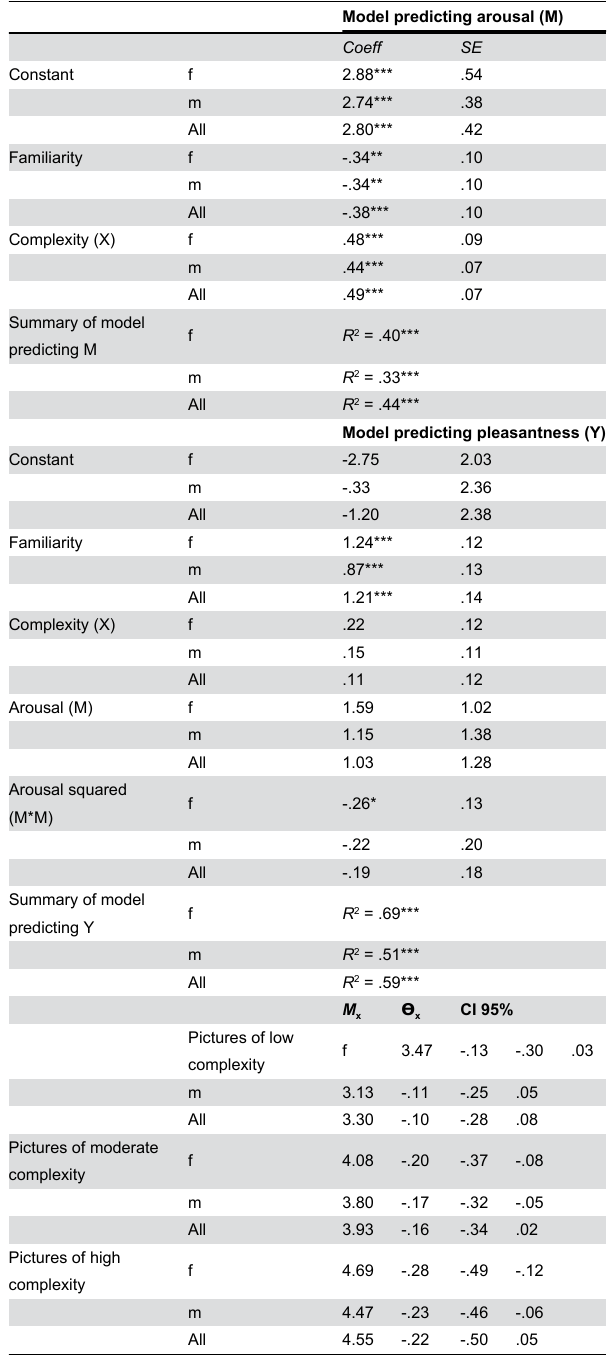
Table 6. Indirect effect of complexity (X) on pleasantness (Y) through arousal (M) calculated for representational paintings (N = 86, n = 87, n = 88), modeled with a All males females quadratic relation between M and Y and familiarity as a